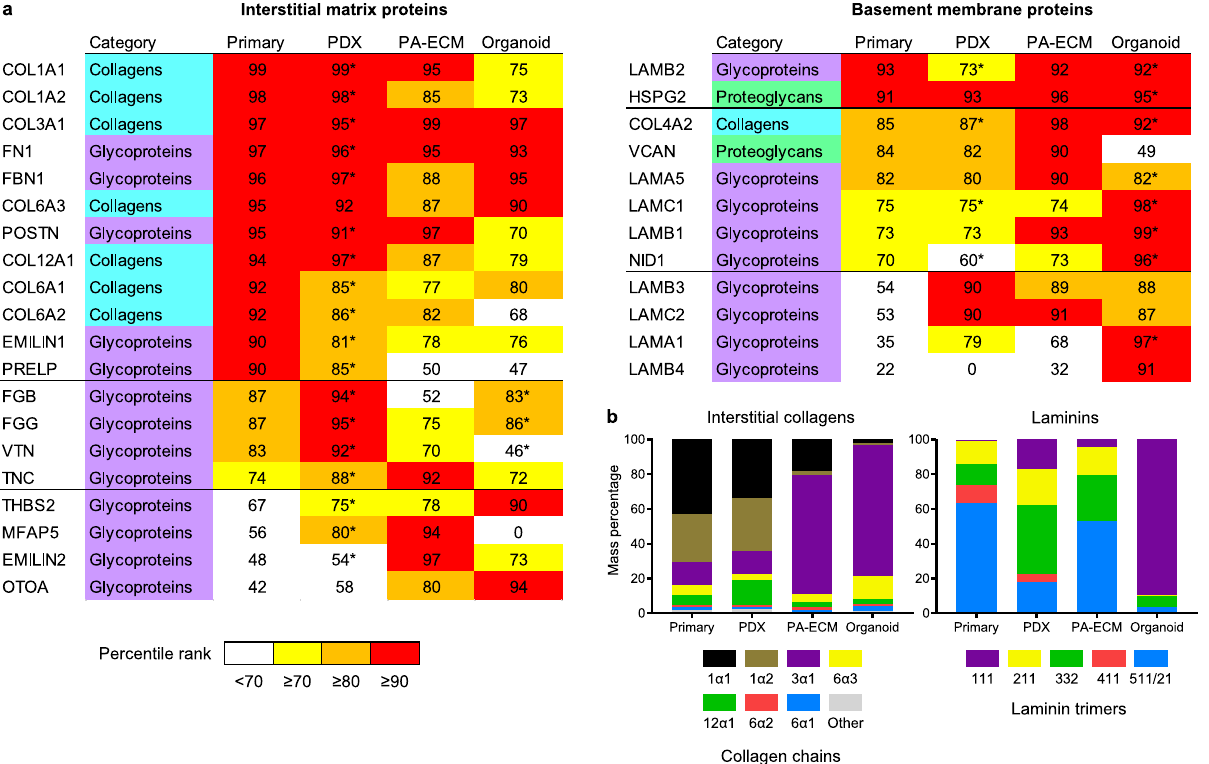
Fig. 6 Core matrisome recapitulation in PDX, PA-ECM and organoid models. a Heatmap of the top matrisome proteins detected which fall on or above the 90th percentile rank in abundance (mean across all patients) in at least one of the sample categories. For the PDX and Matrigel samples, abundance was calculated as the sum of the human and murine peptides. Those proteins for which >50% of the peptides detected were of murine origin are indicated with an asterisk. b Distribution of interstitial collagen chains and laminin trimers for all sample categories. Data correspond to the mean across all